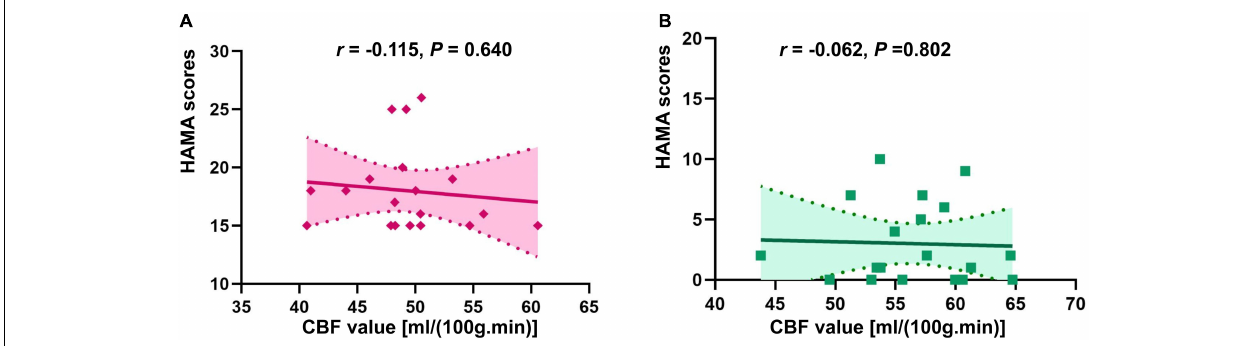
FIGURE 4 | Correlation analysis of CBF in brain regions with difference (Insula_R/Heschl_R) and HAMA score in two groups. (A) The correlation analysis in anxiety group. (B) The correlation analysis in non-anxiety group.